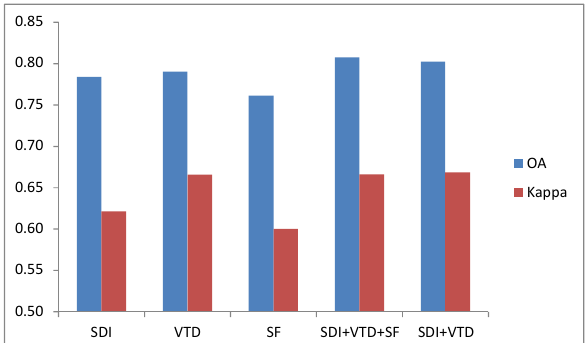
Figure 2. Overall Accuracies (OA) and Kappa coefficient for different feature spaces or combination of them: statistical description indices for fixed periods (SDI); single descriptors of vegetation temporal dynamics (VTD); and parameters of sinusoidal functions (SF).